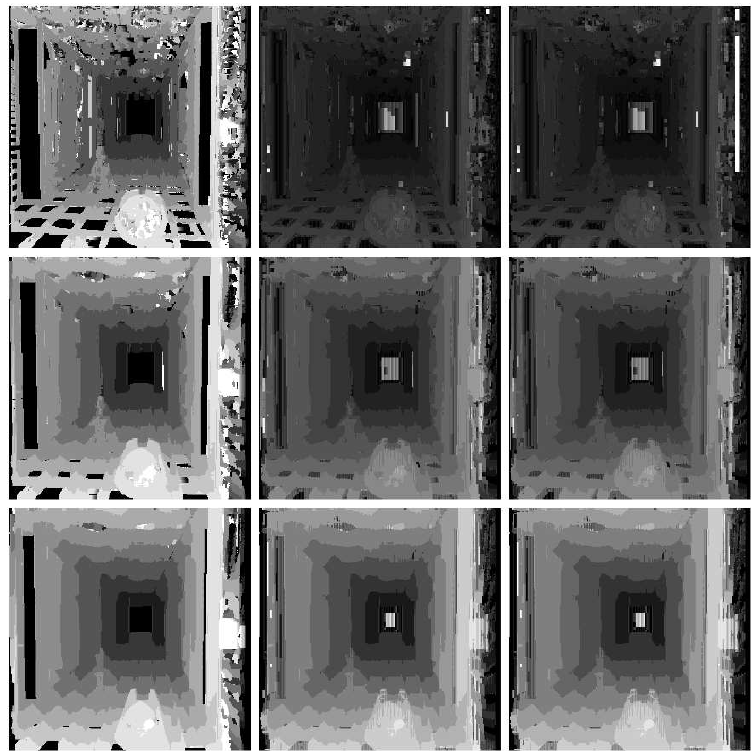
Figure 14. Visual comparison for the Corridor images between disparity maps generated by correlation (right column) and multiresolution matching with δ ∈ { 0 . 1 , 0 . 2 } (middle and left columns, respectively), using windows of size 5 , 9 , 13 (top, middle and bottom rows, resp.),